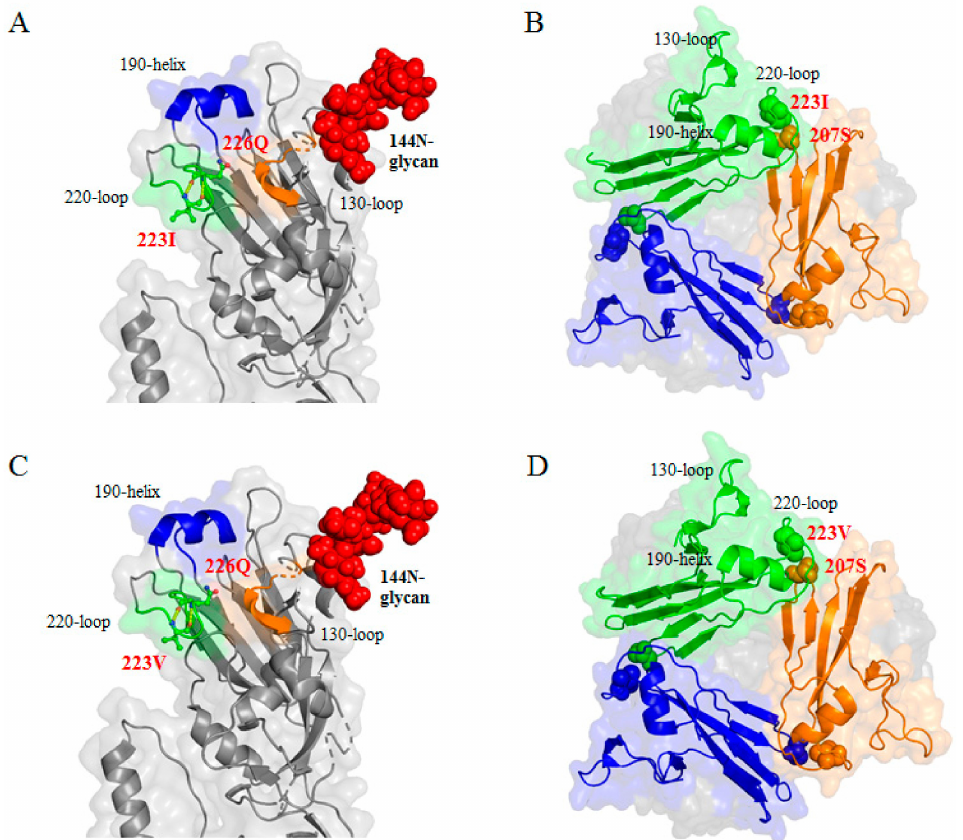
Figure 5. Location and intermolecular interaction of 144N and 223V / I residues in the 3D structure of the HA trimer. HA and HA trimer structure were modified from 4juk.pdb and 6e7g.pdb using PyMOL. ( a ) 223I and ( c ) 223V were located in the 220-loop of the receptor binding site (RBS) of the globular head. Position 223 was close to position 226Q, and both 223I and 223V interacted with 226Q by hydrogen bond (dotted line). ( a ), ( c ) 144N followed by 145S and 146S were located near the RBS, and 144N glycosylation was formed by N-X-S / T. ( b ) 223I and ( d ) 223V were close to the 207S of another HA monomer, and 223I had more side chains extruding and was much closer to 207S than 223V.